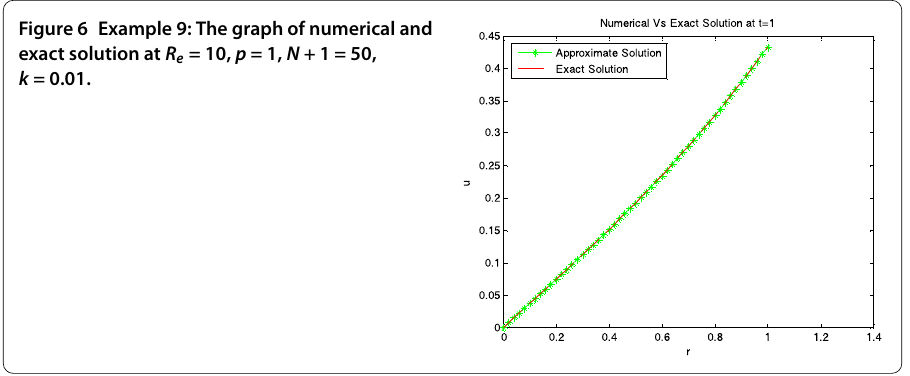
Figure 6 Example 9: The graph of numerical and exact solution at R e = 10, p = 1, N + 1 = 50, k =